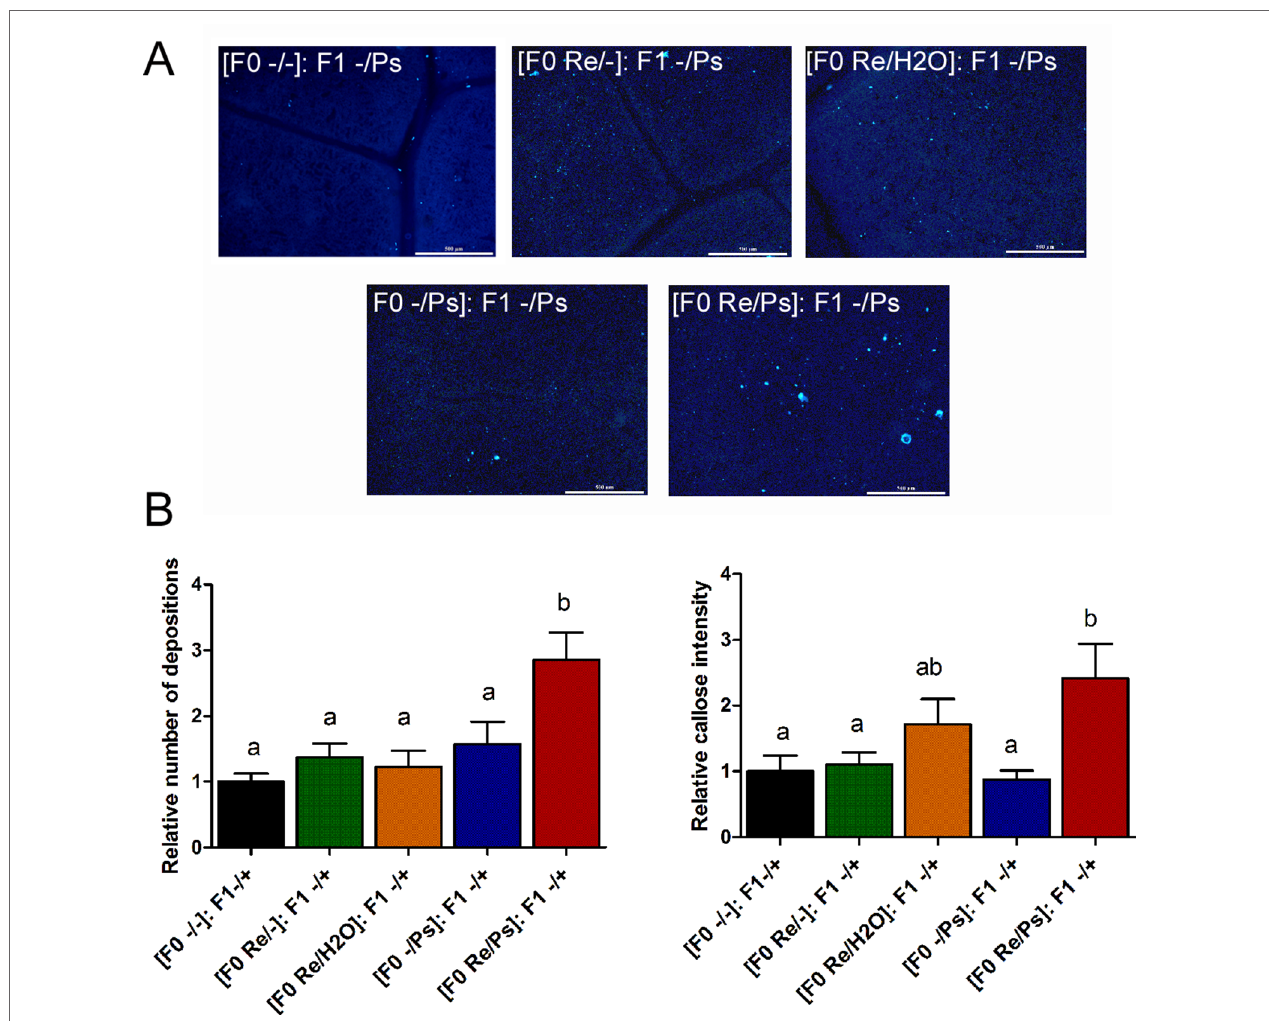
FIGURE 11 | Phenotype of R. etli-induced callose in F1 generation. (A) Morphological differences of callose depositions in 17 days-old P.vulgaris F1 plants. Seeds from the F1 progenies were germinated and exposed to the pathogen only, without rhizobacteria treatment. Representative photographs of aniline blue- stained leaves under UV epifluorescence illustrate differences in callose deposition between treatments. (B) Relative quantification of callose (number of individual depositions per unit of leaf surface) and callose intensity (number of fluorescent callose-corresponding pixels relative to the total number of pixels) were determined by using the Fiji software (according to Jin and Mackey, 2017). Values represent means (±SEM, n=24). Statistical significance was determined using one-way ANOVA followed by Tukey’s multiple comparison test, p < 0.05). Scale bar = 500 µm. Means with the same letter are not significantly